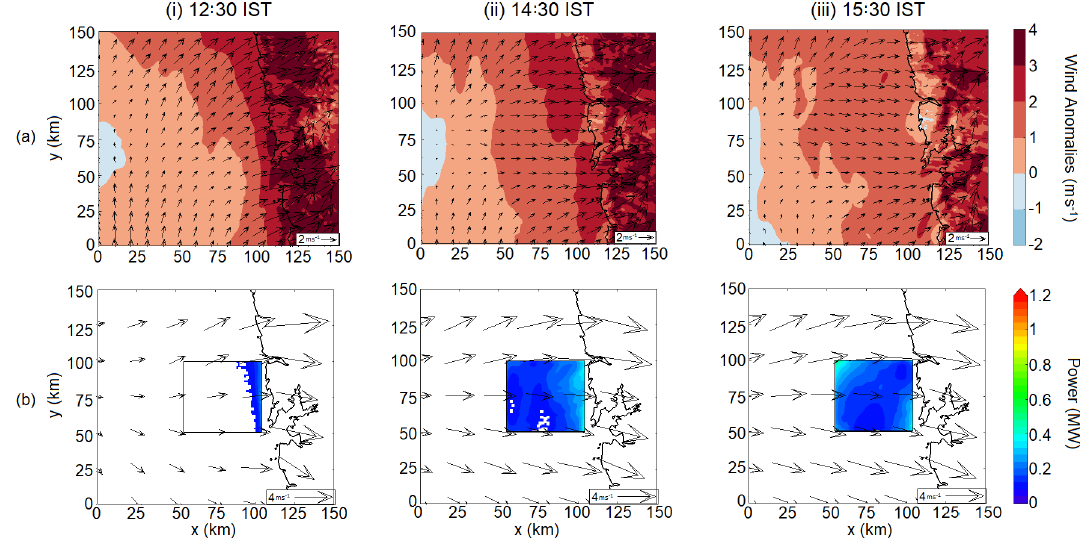
Figure 4. (a) Wind anomalies and (b) power production for 7 April 2019, at (i) 12:30IST, (ii) 14:30IST, and (iii) 15:30IST.